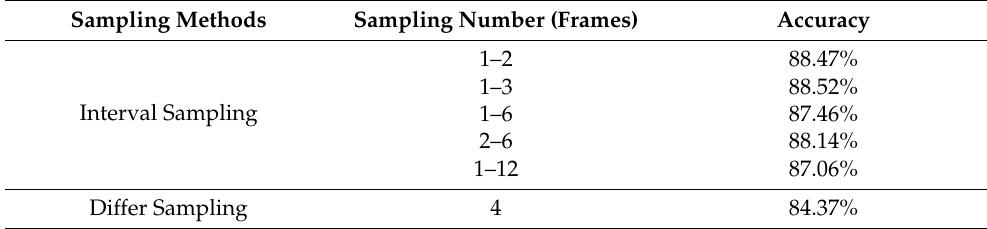
Table 6. Different sampling methods of LSF. Results are reported in terms of RANK 1 identification accuracy (%) on LRW.